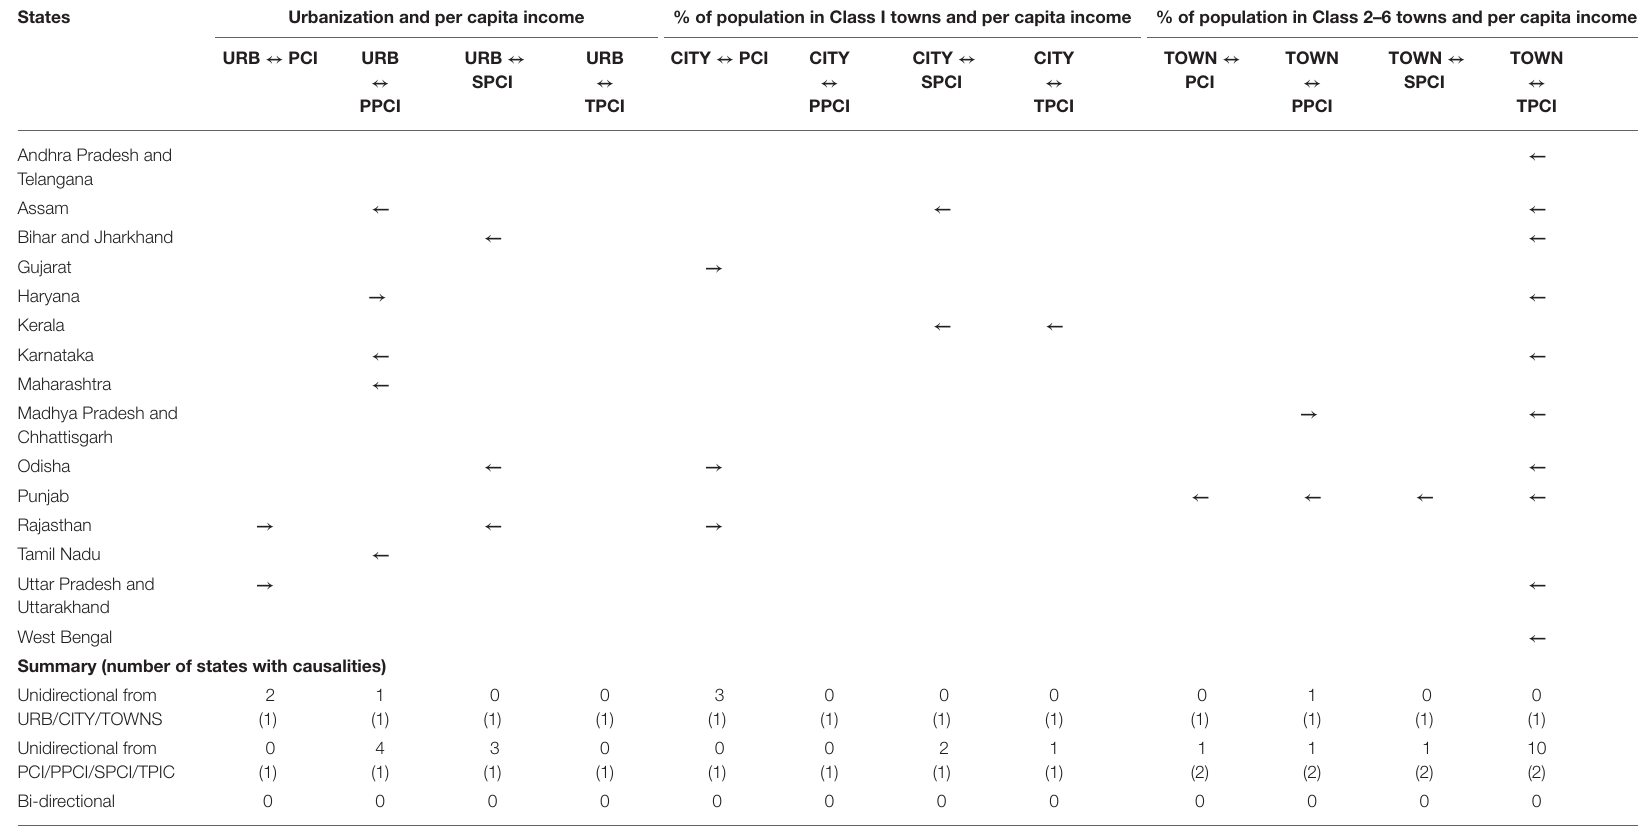
TABLE 3 | Granger causality between the log of urbanization and log of per capita income in the Indian states in the pre-liberalization period (1971–1991).